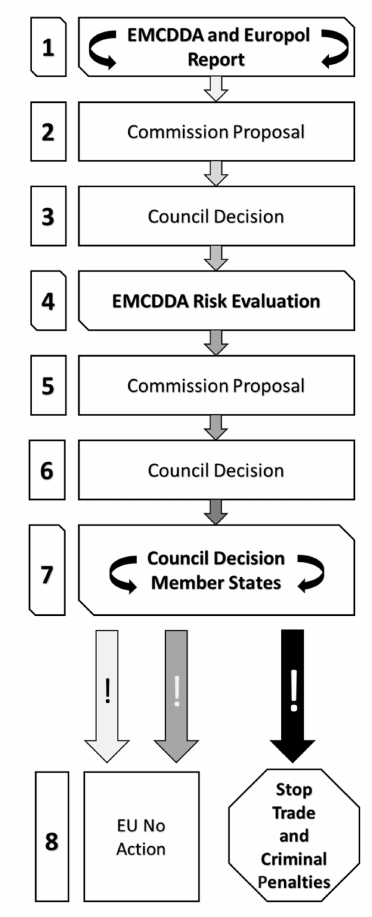
Figure 1. Procedure applied according to the European Council Decision 2005 / 387 /